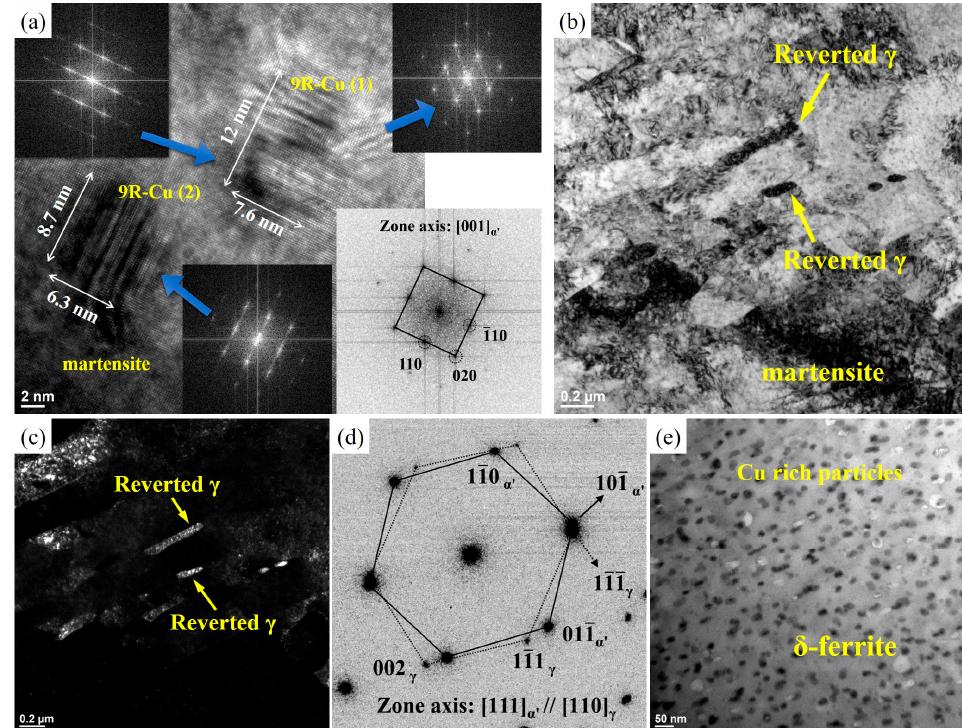
Figure 8. Samples aged after liquid N2-quenched solid solution treatment. ( a ) Nano 9R-Cu rich particles in martensite matrix with diffraction patterns; ( b ) collapsed lath martensite and reversed γ ; ( c ) dark field of reversed γ ; ( d ) orientation relationship (OR) between martensite α ’ and reversed austenite γ ; ( e ) nano Cu-rich particles in δ ferrite.